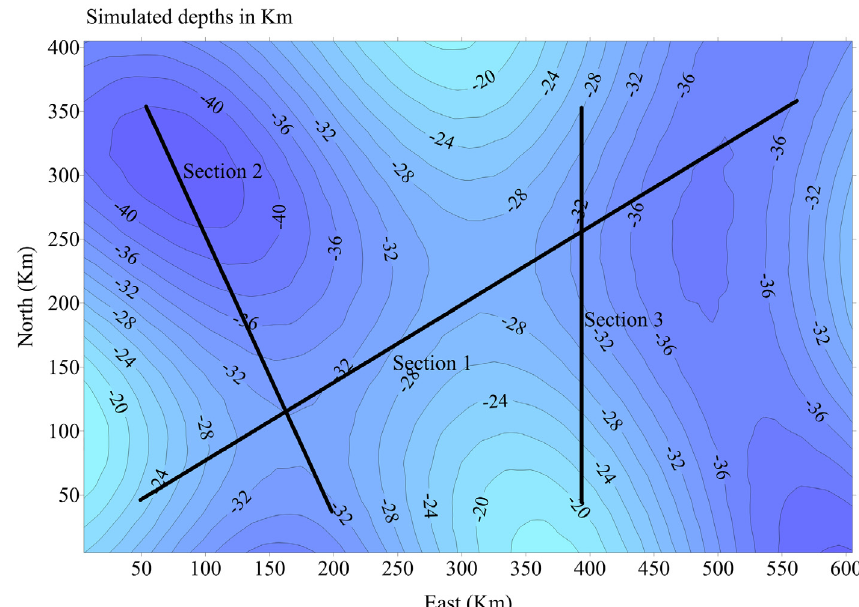
Figure 2. Simulated